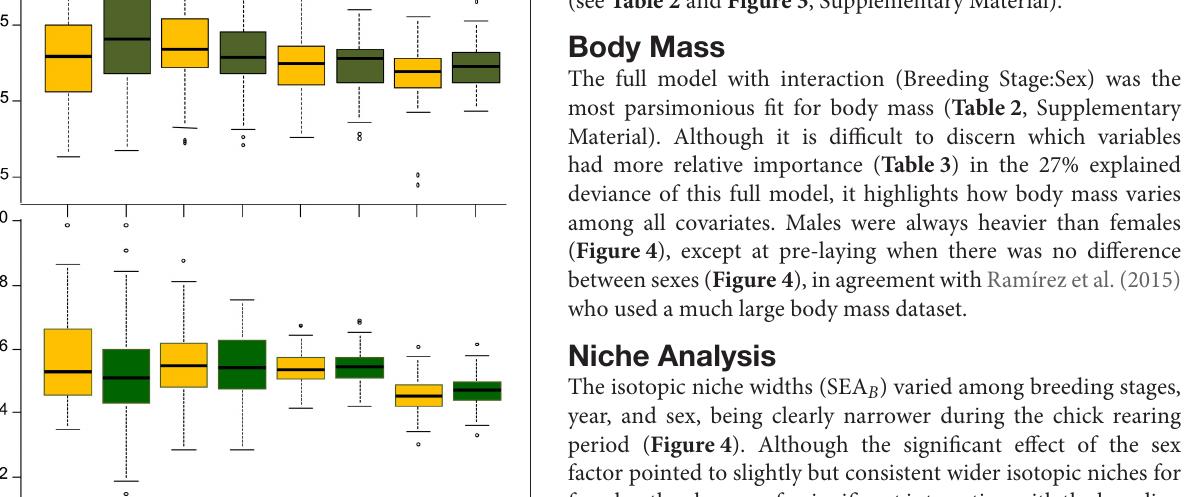
Frontiers in Ecology and Evolution |